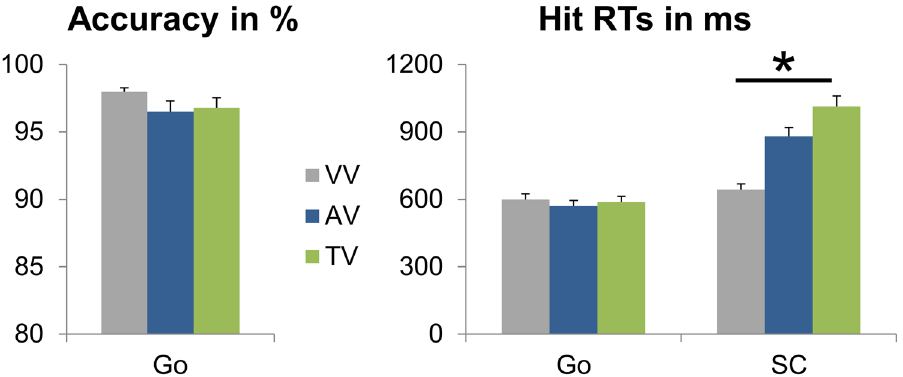
Figure 2. Task version differences in the behavioral data. VV = visual task version, AV = audio-visual task version, TV = tactile-visual task version. Please note that accuracy was not assessed for the SC condition, as the applied staircase procedure affects the accuracy in this